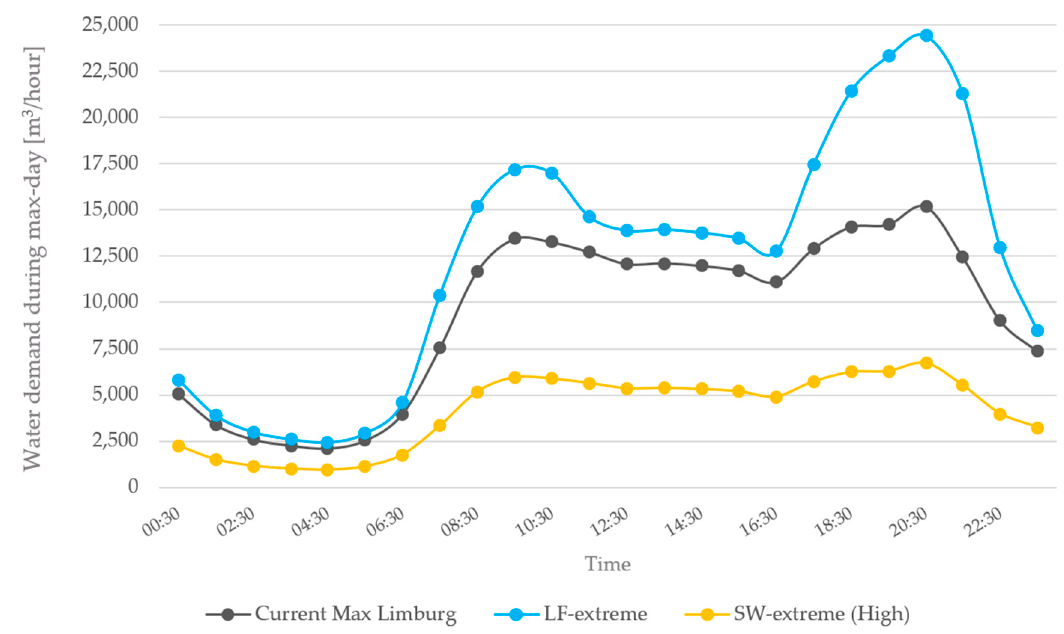
Figure 7. Water demand during max-day (peak) of Limburg for different socio-technical scenarios.